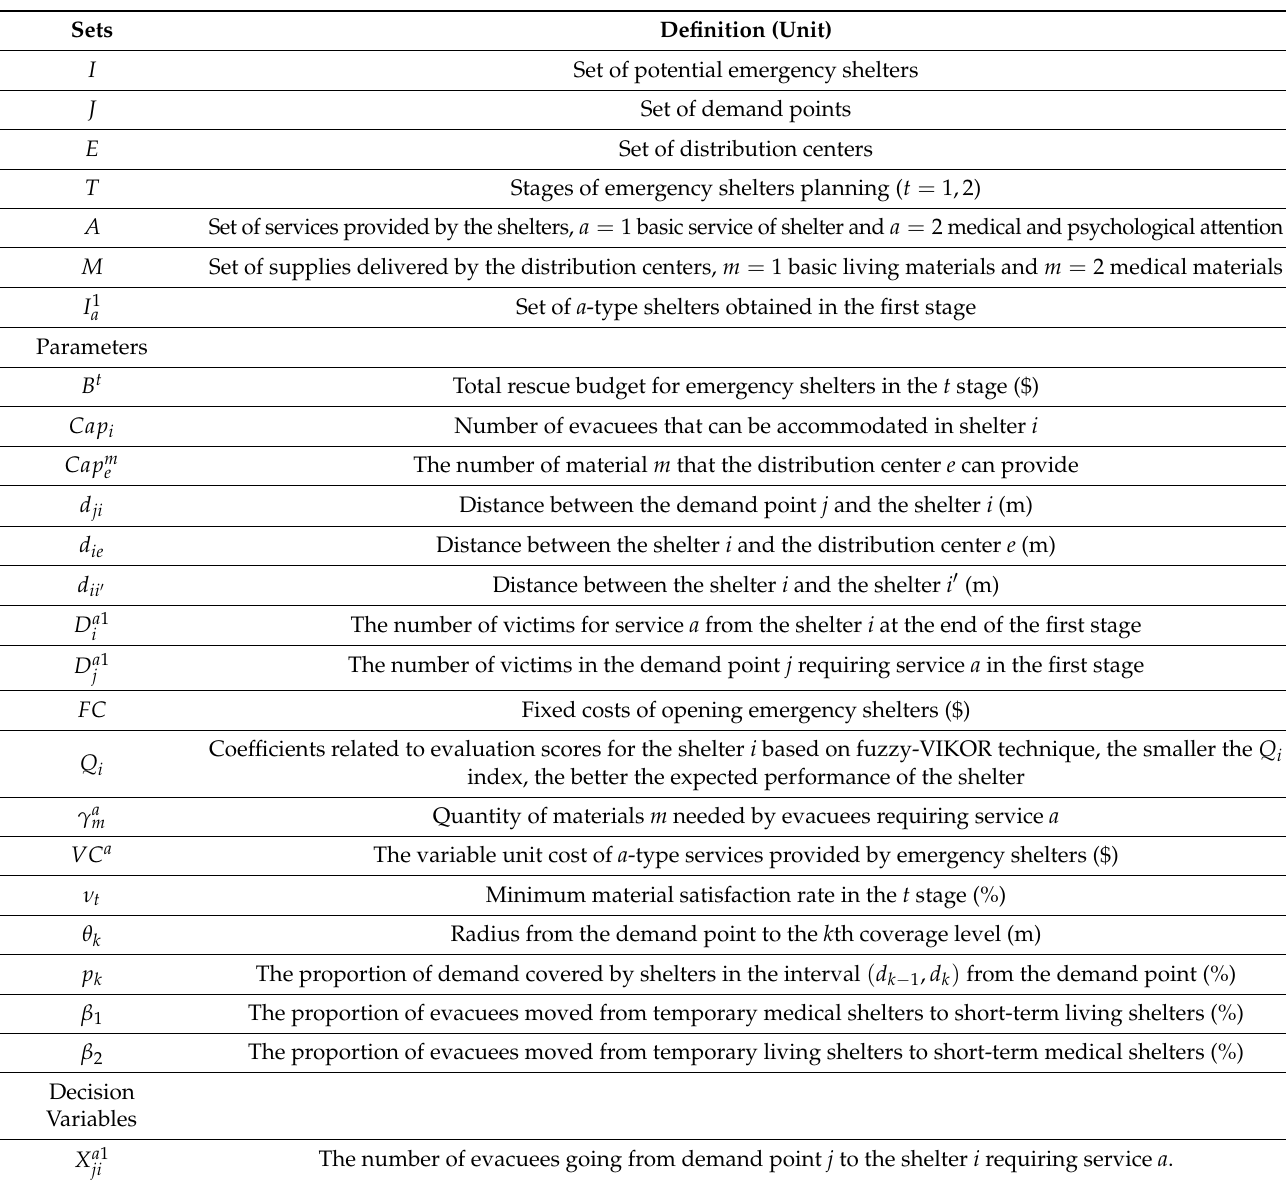
Table 3. The definition of the sets, parameters, and decision